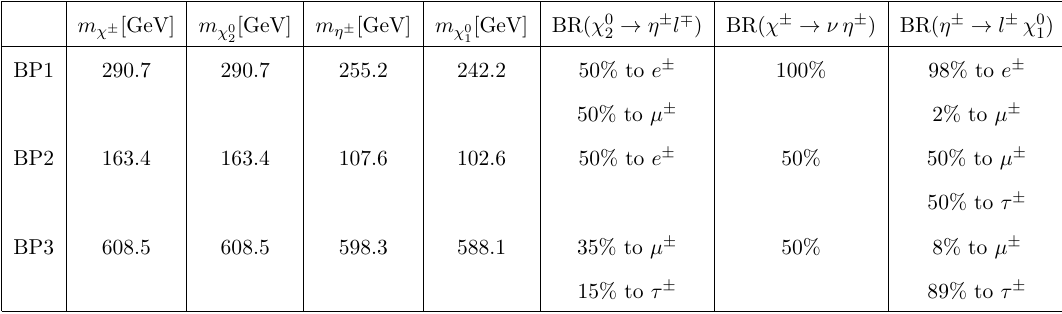
m (cid:31) (cid:6) [GeV] m